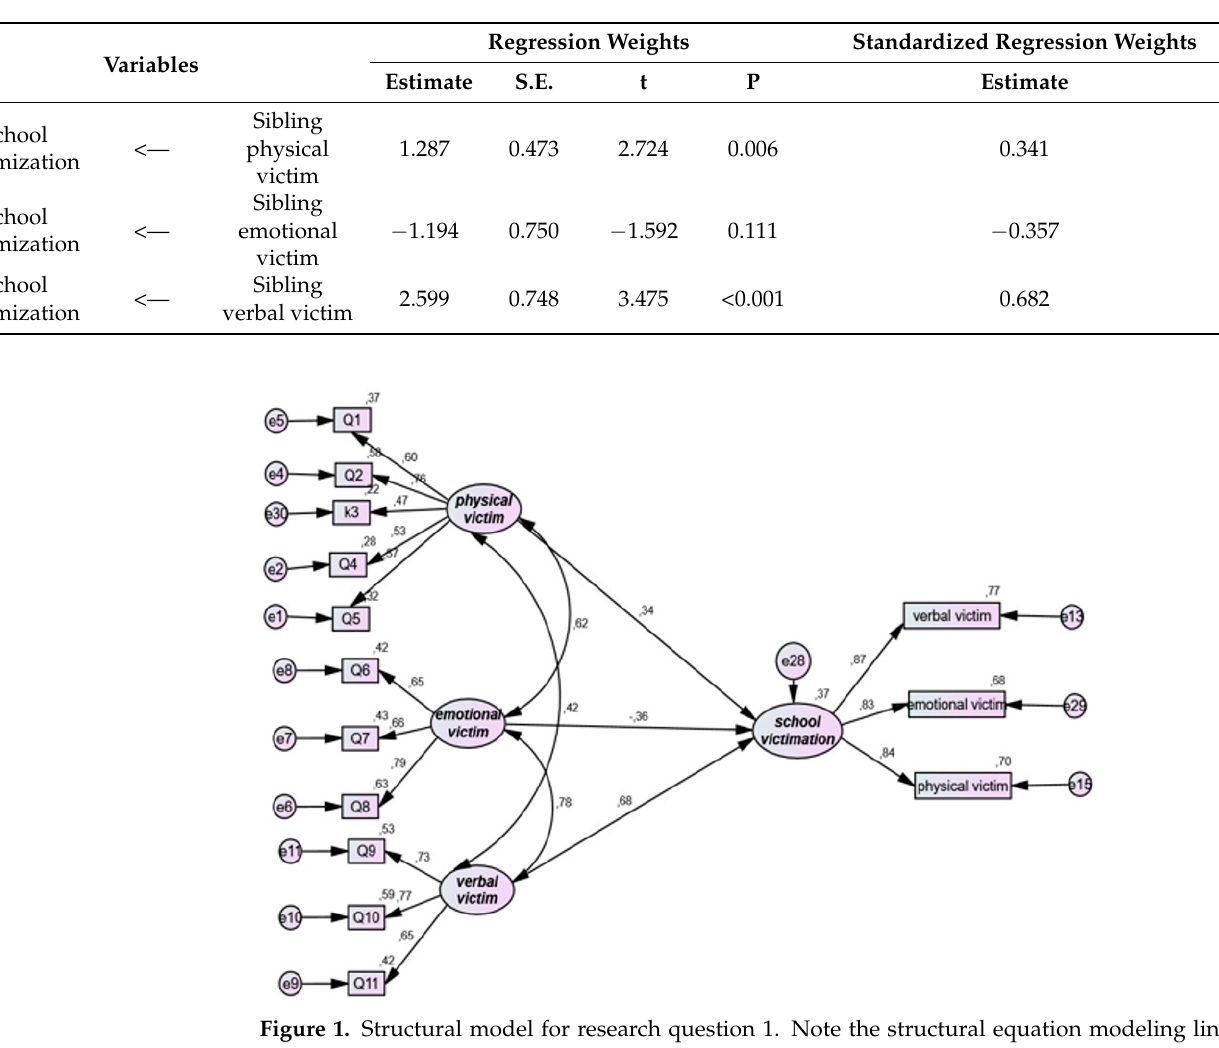
Figure 1. Structural model for research question 1. Note the structural equation modeling links be ‐ tween physical, emotional, and verbal bullying practiced against the brothers (the victim) as an in ‐ dependent variable and school victimization as a dependent